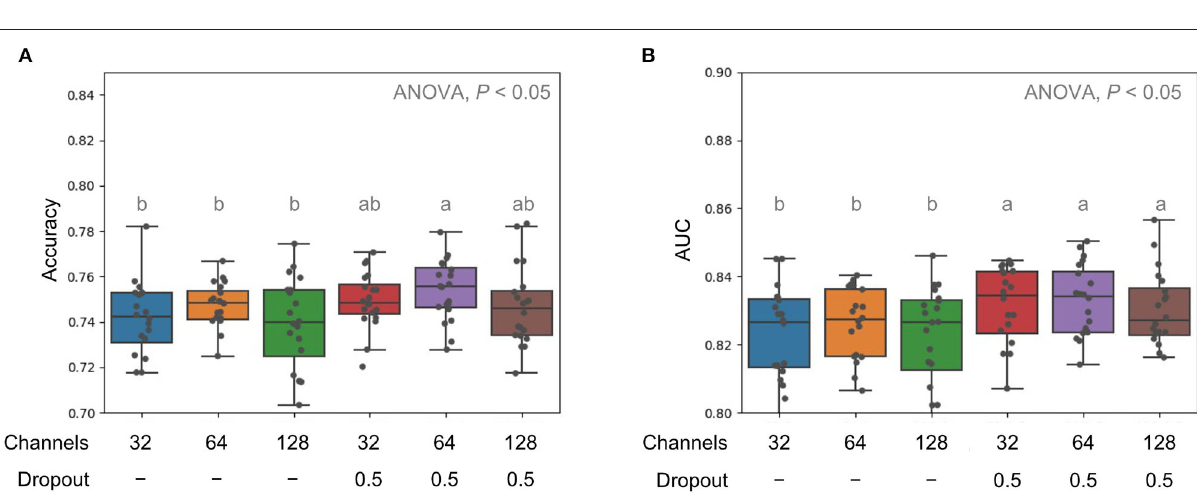
FIGURE 3 | Comparison of model performance in terms of accuracy (A) and AUC (B) for with different channel sizes and dropouts. Multiple comparison tests on the different units were applied in the models using one-way ANOVA, following the post-hoc Tukey HSD test for paired difference with a p -value < 0.05. Different letters indicate a significant